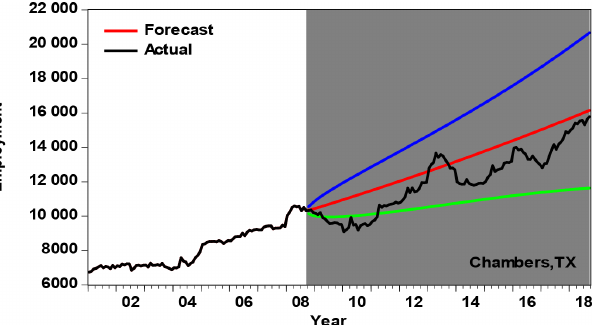
Figure 4. Temporary effects of Hurricane Ike in Chambers County.